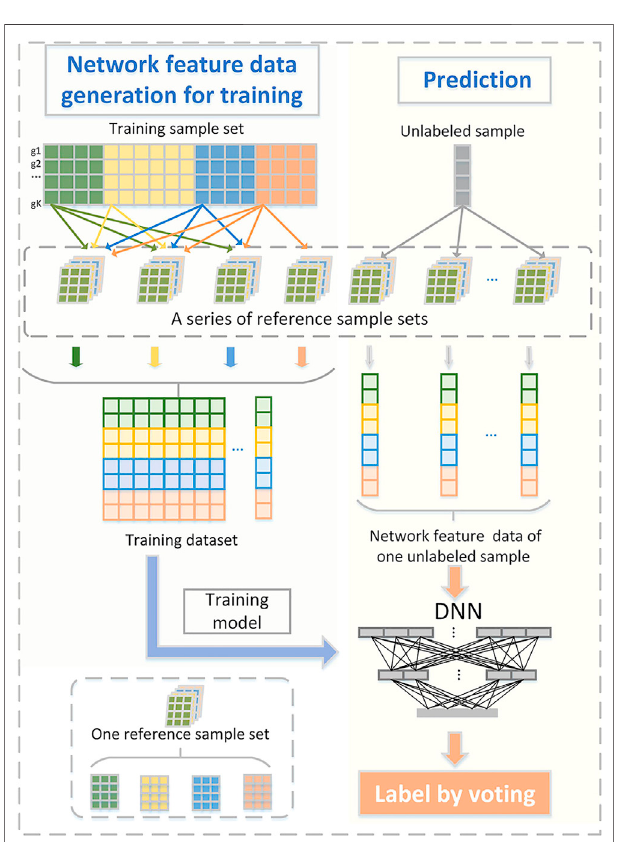
FIGURE2 | Suf fi cient networkfeaturedatagenerationfor model training andprediction.OnereferencesamplesetconsistsofTgroupsofsamplesthat from T subtype (T: total number of subclass). Network feature data corresponding to training samples are used for model